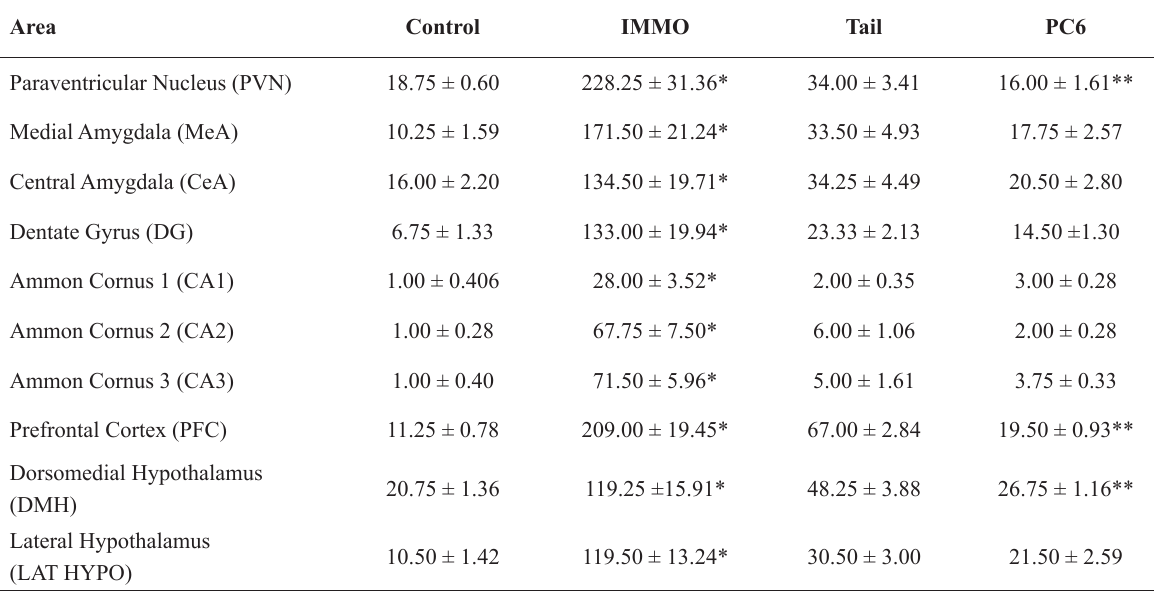
Fos - immunoreactive cells (Fos-ir) in brain areas of control rats and rats submitted to immobilization (IMMO) and IMMO plus electroacupuncture at the tail or at PC6